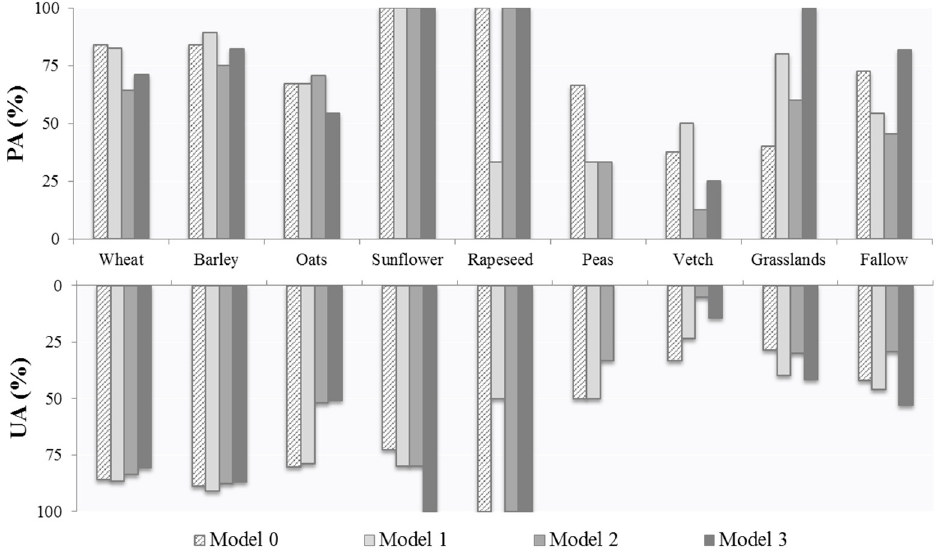
Figure 6. UA and PA for the different crops and classification schemes (models) tested.